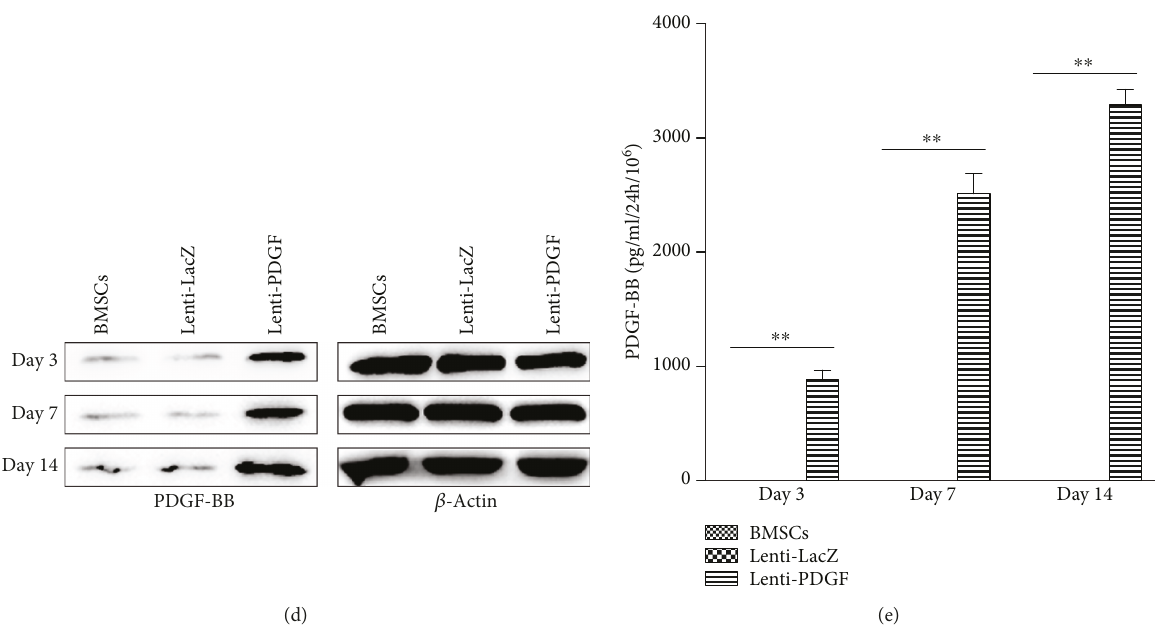
Figure 1: Detection of PDGF-BB expression. (a) At day 3 after gene transduction, both Lenti-LacZ-transfected and Lenti-PDGF-transfected BMSCs grew well and exhibited intense green fl uorescence. (b) Flow cytometry assay showed 82.41% transfection e ffi ciency. (c) PDGF-B mRNA expression in the BMSC, Lenti-LacZ, and Lenti-PDGF groups on days 3, 7, and 14. (d) PDGF-BB protein expression in the BMSC, Lenti-LacZ, and Lenti-PDGF groups on days 3, 7, and 14. (e) ELISA detection of PDGF-BB secretion in vitro . Scale bar: 100 μ m; ∗∗ P < 0 01